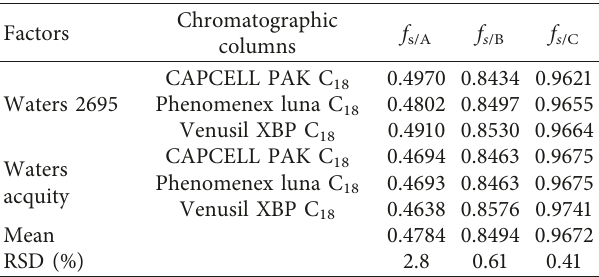
Table 4: Taking the berberine hydrochloride as the internal standard to calculate the RRT